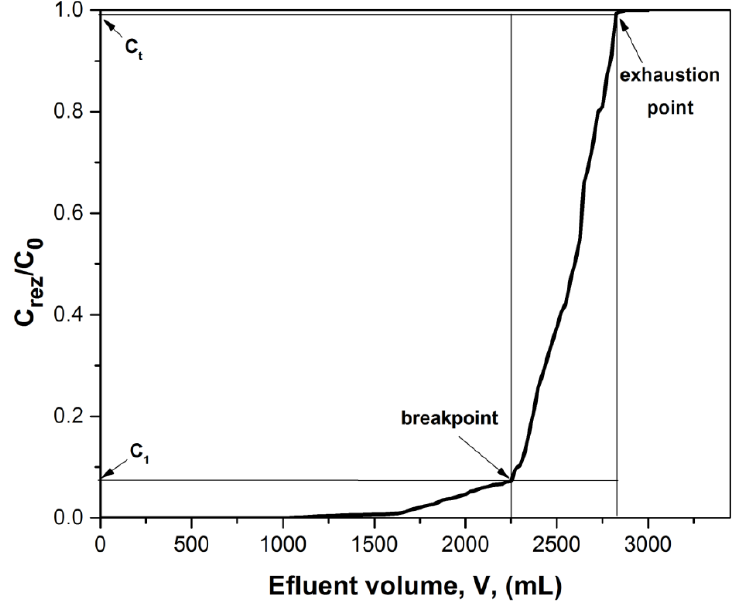
Figure 4. A representation of the breakthrough curve with mass transfer zone (MTZ) at an amount of 10g adsorbent material inserted in the column. 10g adsorbent material inserted in the